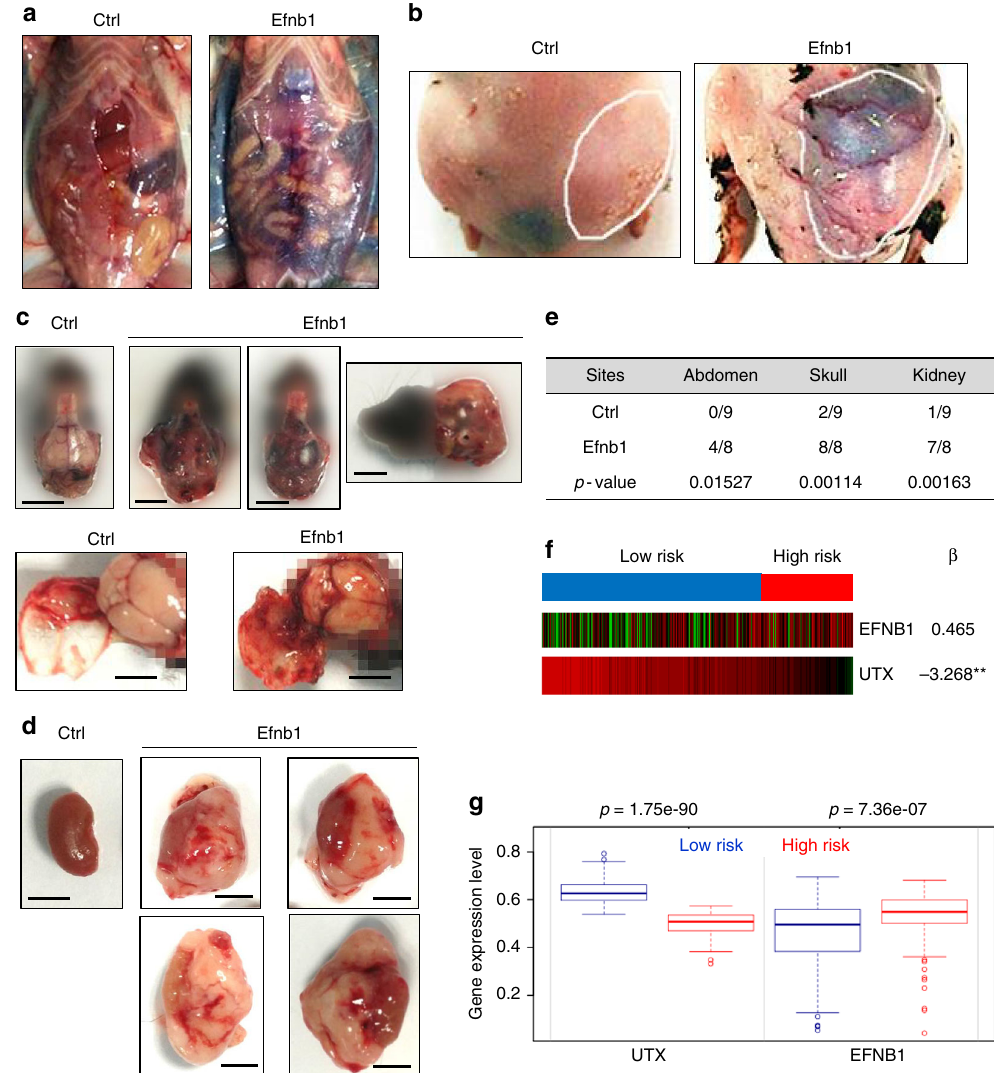
Fig. 4 Ectopic expression of Efnb1 in E μ -Myc;p19 Arf − / − cells promotes tumor dissemination and blood vessel formation in vivo. a – d Representative dissection images of mice injected with Efnb1-expressing lymphoma cells or control cells. a Abdomen cavities. b Blood vessel formation around the tumor. c In fi ltration of lymphoma into brain. Bar, 5 mm. d In fi ltration of lymphoma into kidney. Bar, 5 mm. e Summary of lymphoma in fi ltration or dissemination sites. Ctrl, n = 9, Efnb1, n = 8. The p -values are determined by the chi-squared test. f The pairwise expression of UTX and Efnb1 from dataset Lenz Staudt Lymphoma GSE10846. N = 420. Prog.Idx. Prognosis Index. Corresponding beta coef fi cients from the Cox fi tting is shown. Two stars (**) marks genes whose fi tting p -value < 0.01, one star (*) marks genes whose fi tting p -value < 0.05, and no stars for genes whose p -value is > 0.1, log-rank test. g The expression level of UTX and Efnb1 in high risk and low risk